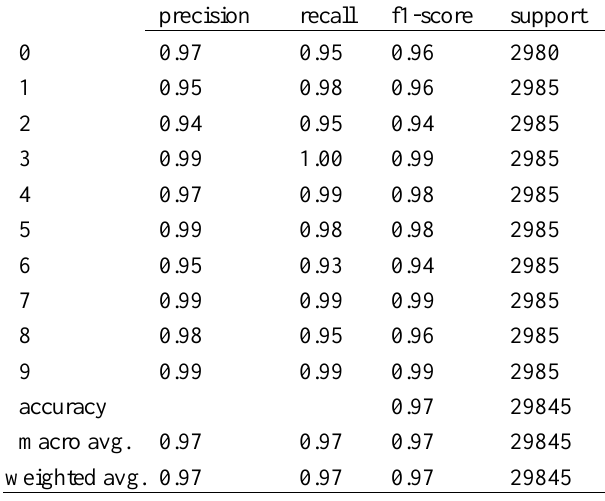
Fig. 11. English and Urdu numerals